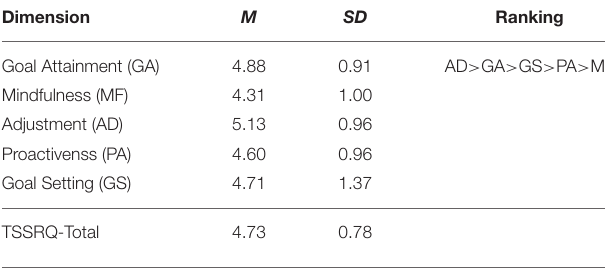
TABLE 7 | Independent t -test of TSSRQ total score with gender and one-way analyses of TSSRQ with grade level and study